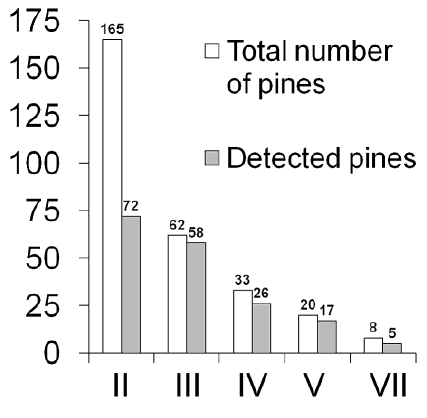
Figure 4. Number of detected pines per age class for the field plots listed in Table 3.